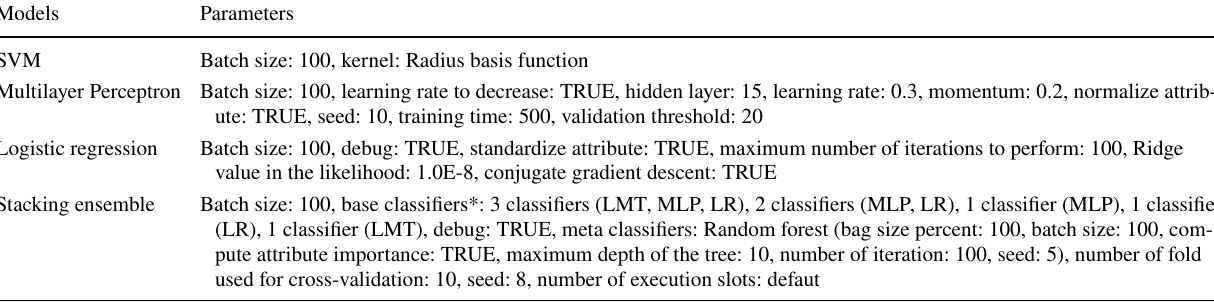
Table 1 Optimum parameters for stacking model for generating GPM